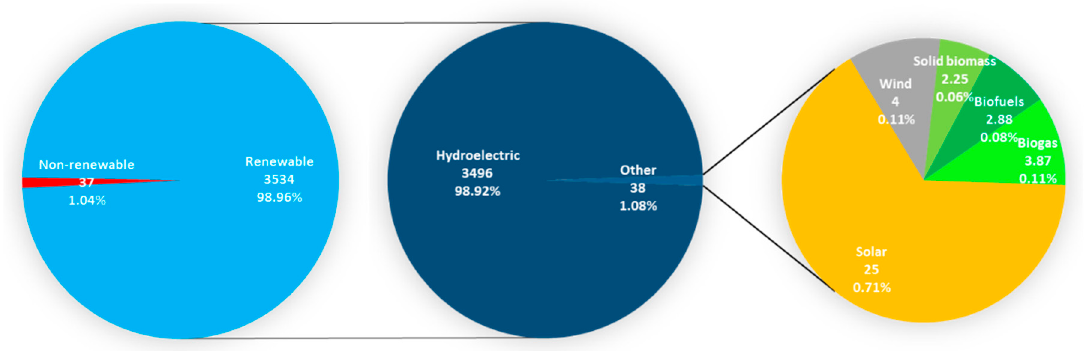
Figure 8. Electrical energy produced in Aosta Valley in 2018 (in GWh).